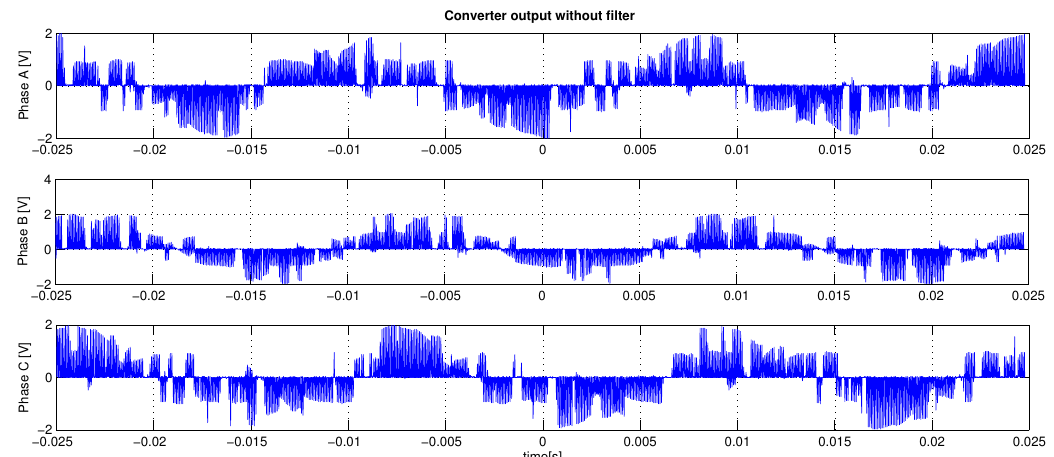
Figure 16. Graph of converter outputs without the filter.